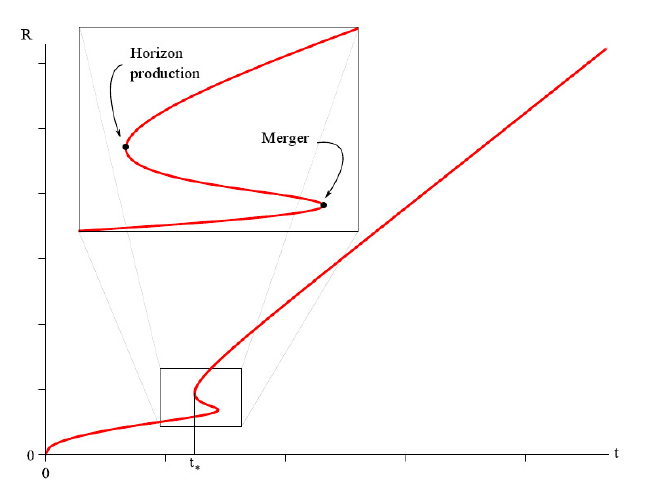
Figure 3. The radii of the apparent horizons of the Husain-Martinez-Nuñez spacetime versus the FLRW √ comoving time for α = 3/2 ( t and R are in arbitrary units of length and the parameter values are such that ( Ca 0 ) 3/2 = 10 3